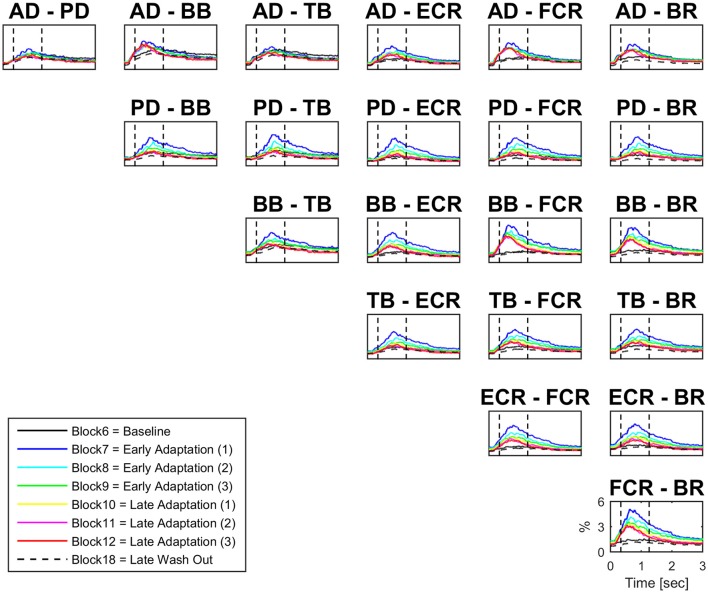
Block-by-block co-contraction profiles for 21 muscles pairs. For each muscle pair block-by-block average (N = 16) co-contraction profiles (from visual cue to 3 s afterwards) have been color coded to describe the evolution of co-contraction over the adaptation period. The most active muscles during adaptation are also the most co-active (e.g., BB-FCR).